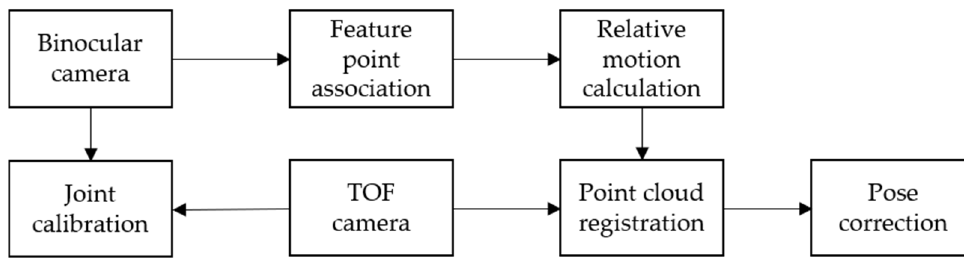
Figure 3. Flow chart of the pose measurement algorithm for non-cooperative spacecrafts.